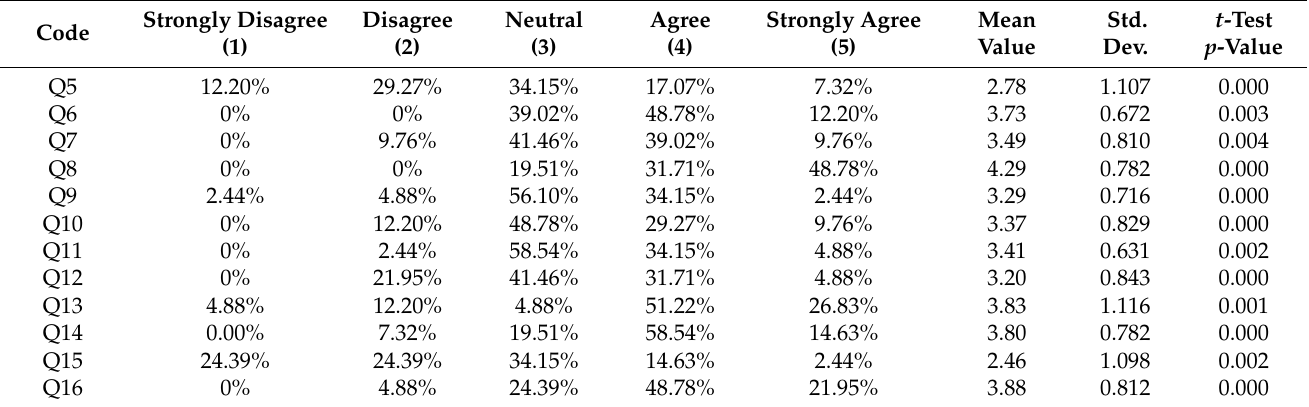
Table 3. Descriptive statistics for measuring the respondents’ readiness for IPD implementation in KSA’s construction